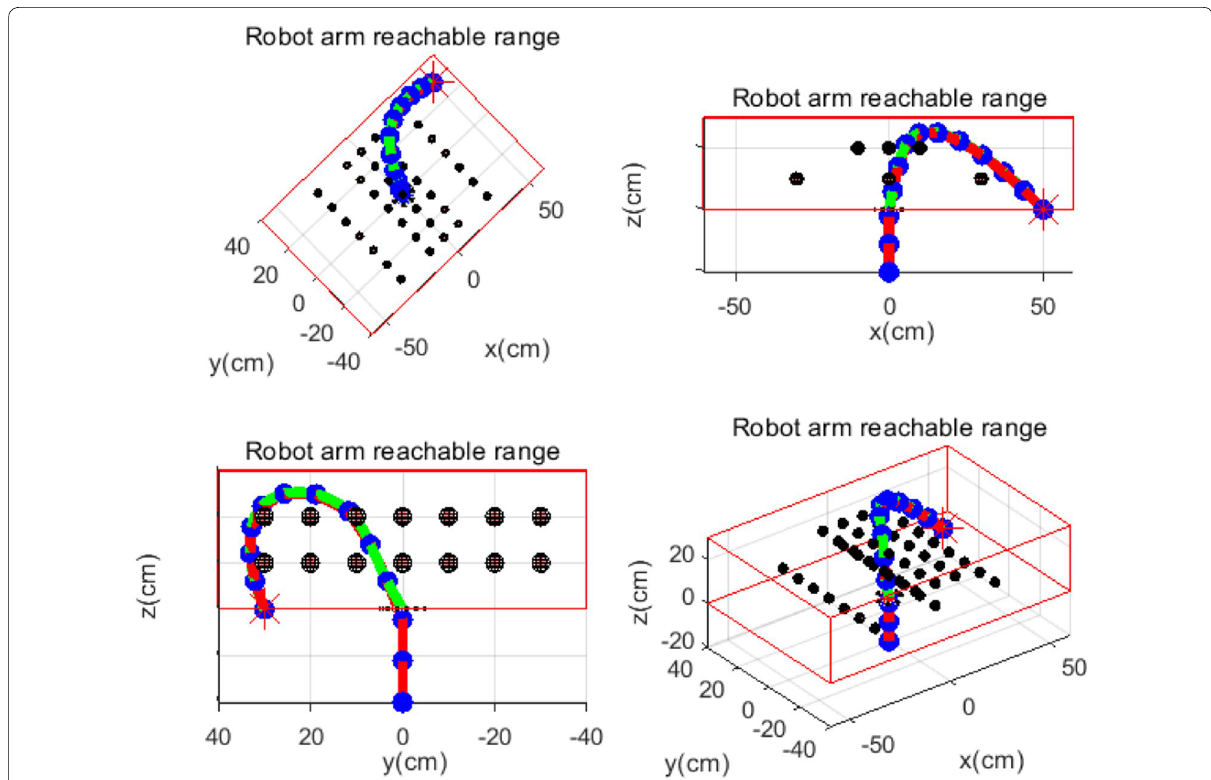
Figure 8 Manipulator tracking